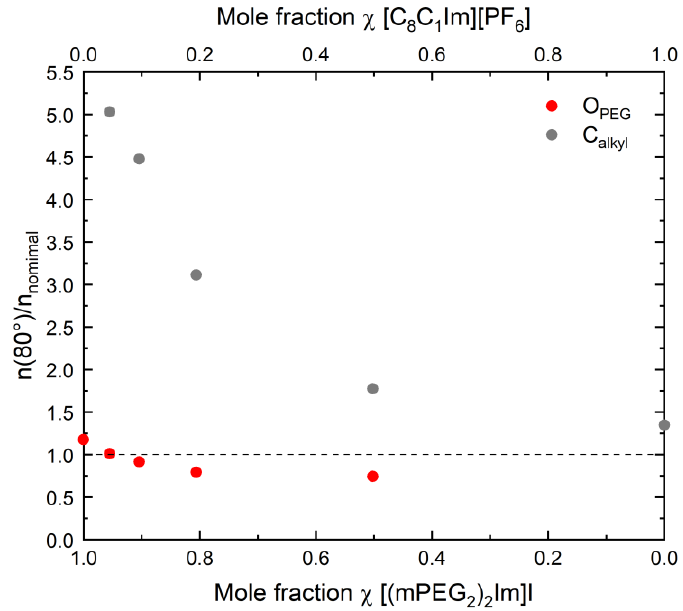
Figure 3. Normalized content n(80 ◦ )/n nominal for O PEG (red) and C alkyl (grey), derived from the corresponding 80 ◦ intensities and the nominal atomic numbers of O PEG and C alkyl for the pure ILs and mixtures at T = 298 K.